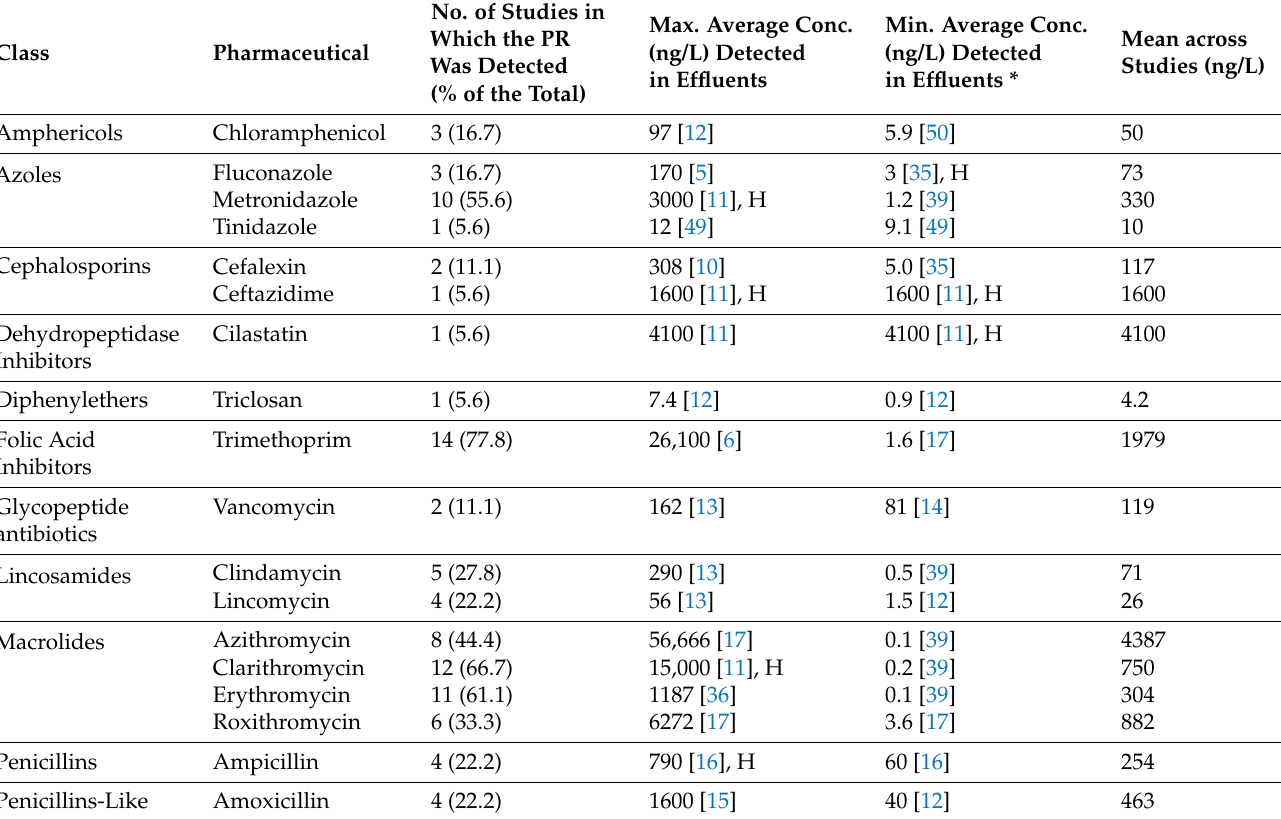
Table 5. List of 45 pharmaceuticals detected in 88 WWTPs, investigated in the eighteen studies. Maximum and minimum average concentrations and means were reported and expressed in